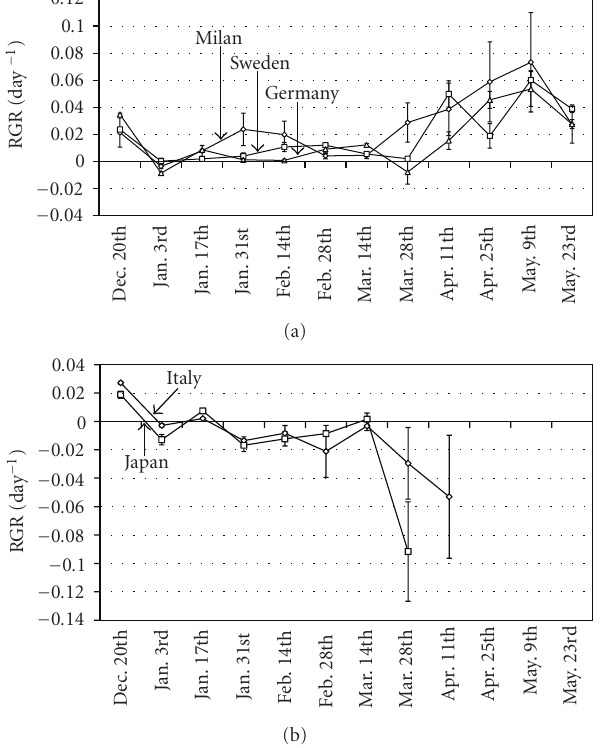
Table 1: Means and Standard Deviations of Carbon and Nitrogen contents (d.w.%) and C/N ratio in Azolla strains from Dec. 2000 to